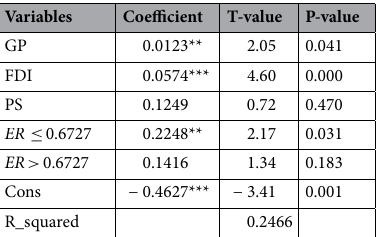
Table 6. Threshold model coefficient and its test. *** and ** respectively indicate that the parameter estimation is significant at the levels of 0.01, 0.05, and 0.1.